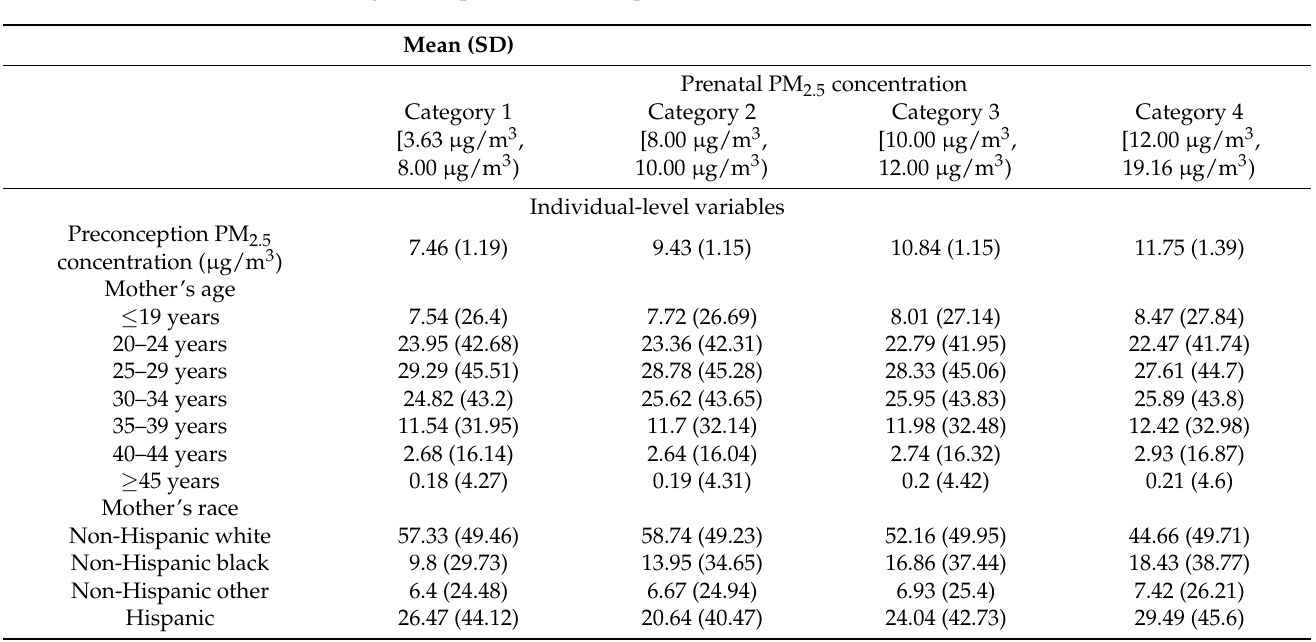
Table A4. Distribution of individual, delivery, and county-level covariates in the analytic sample by categories of prenatal PM 2.5